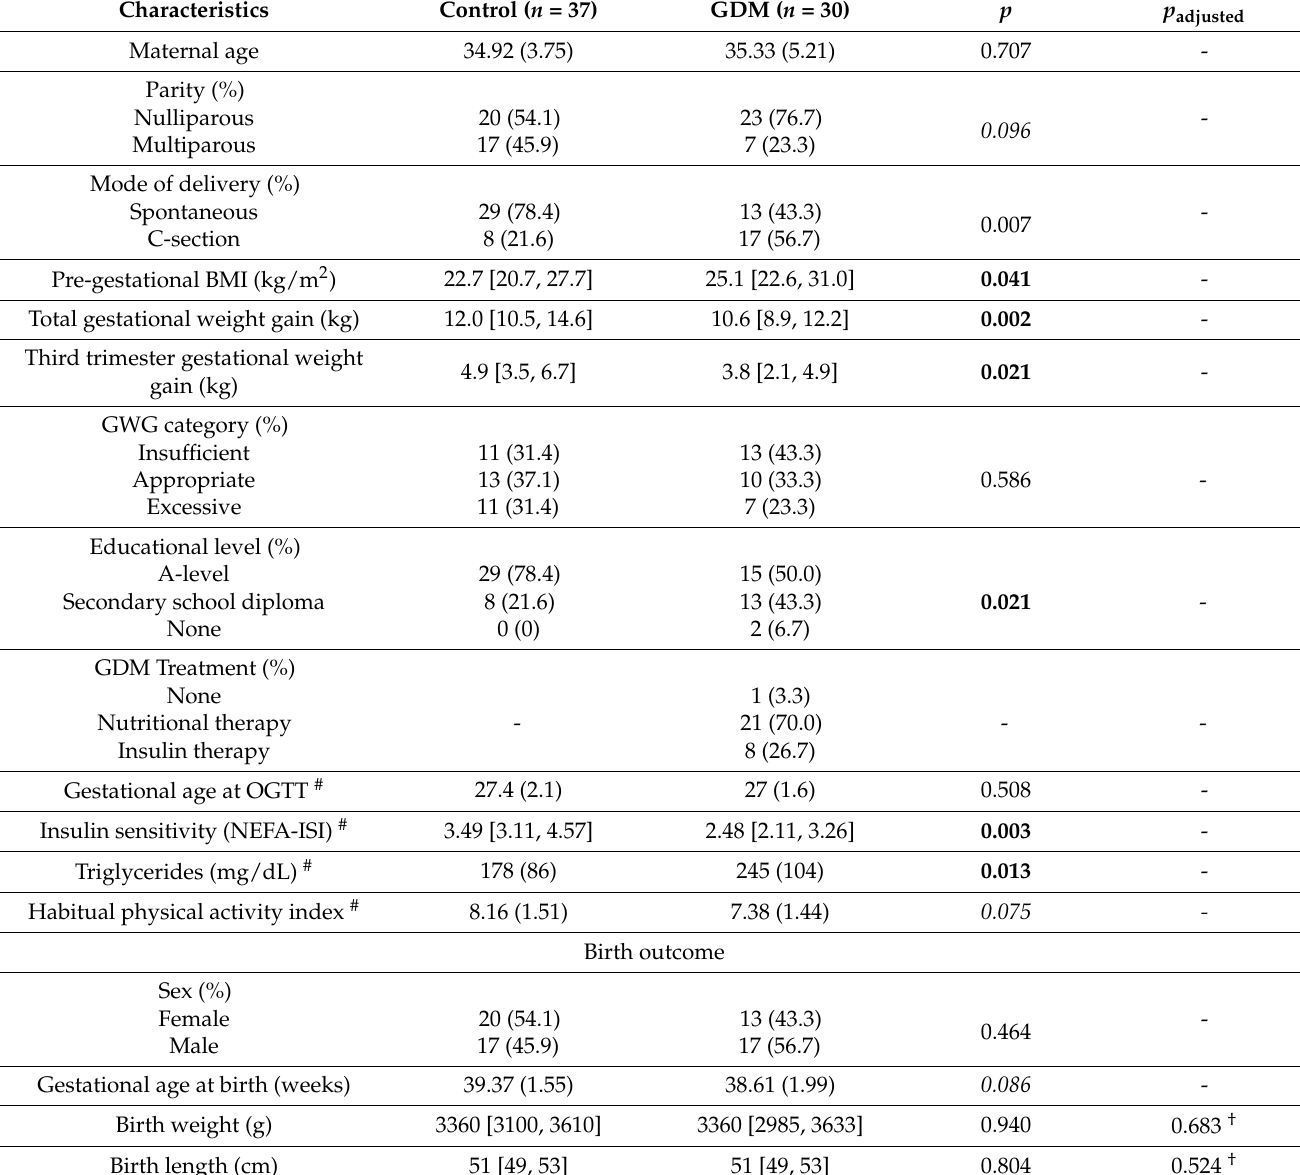
Table 1. Maternal and offspring